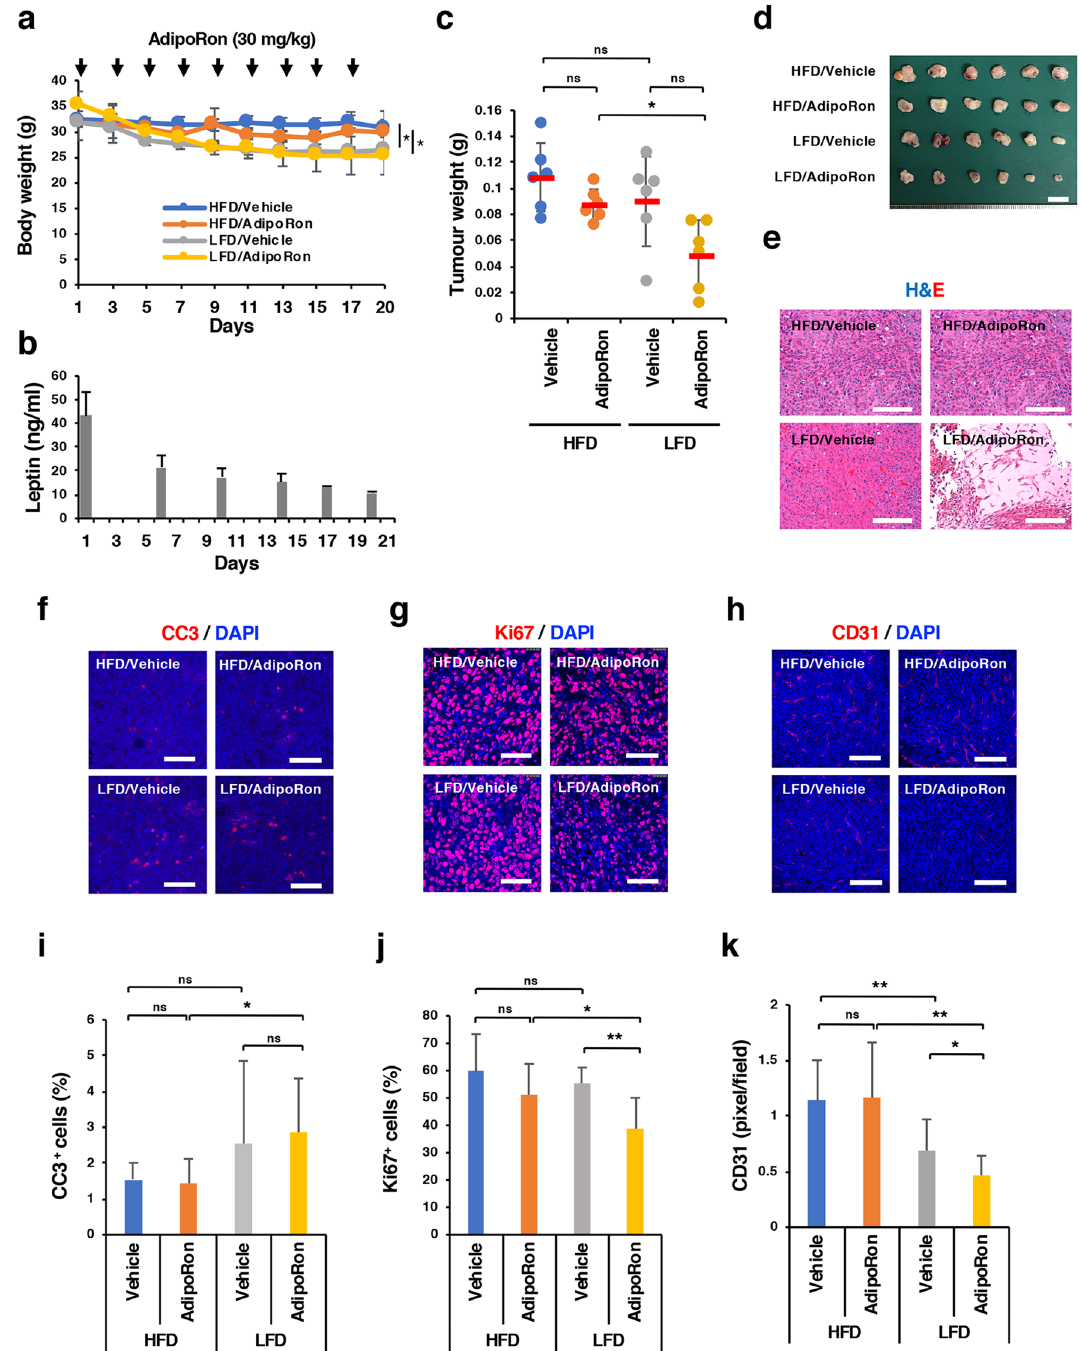
Figure 3. Effect of body weight loss on the anticancer effect of AdipoRon. ( A ) Assessment of body weight after the change of diet from an HFD to an LFD and scheduled AdipoRon administration. DIO mice were orthotopically implanted with Panc02-Luc-ZsGreen cells (2 × 10 5 cells in 50% Matrigel) on day 0 and then randomly divided into four groups (n = 6 mice for each group); mice fed an HFD and intraperitoneally administered vehicle (HFD/Vehicle group) or 30 mg/kg AdipoRon every other day (HFD/AdipoRon group) and mice fed an LFD and intraperitoneally administered vehicle (LFD/Vehicle group) or 30 mg/kg AdipoRon every other day (LFD/AdipoRon group). ( B ) Serum leptin levels after the change in diet from an HFD to an LFD. The DIO mice (n = 5 mice) were fed an LFD from day 1. ( C ) Orthotopic tumour weight in each group (n = 6 mice). ( D ) Tumours. Bar 1 cm. ( E ) H&E staining of tumour tissues from each group. Bars 200 μm. ( F ) Immunostaining of cleaved caspase-3 (CC3) in tumour tissues of each group. Bars 50 μm. ( G ) Immunostaining of Ki67 in tumour tissues of each group. Bars 50 μm. ( H ) H&E staining of tumour tissues from each group. Bars 50 μm. ( I ) The percentage of CC3-positive cells in tumour tissues of each group. ( J ) The percentage of Ki67-positive cells in tumour tissues of each group. ( K ) The number of tumour vessels in tumour tissues of each group. *P < 0.05, **P < 0.01, ns, not